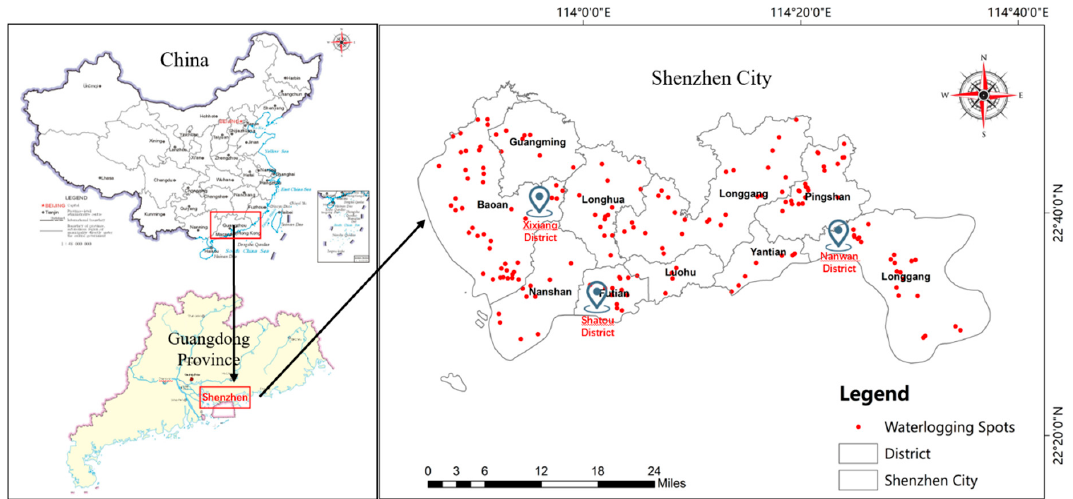
Figure 1. Distribution of research districts in Shenzhen, Guangdong Province, China.